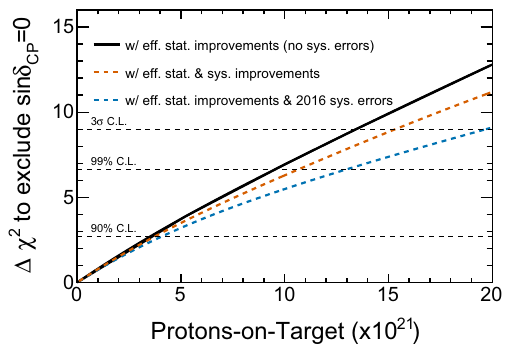
Fig. 77 The sensitivity of T2K as a function of data accumulation (POT) with analysis improvements